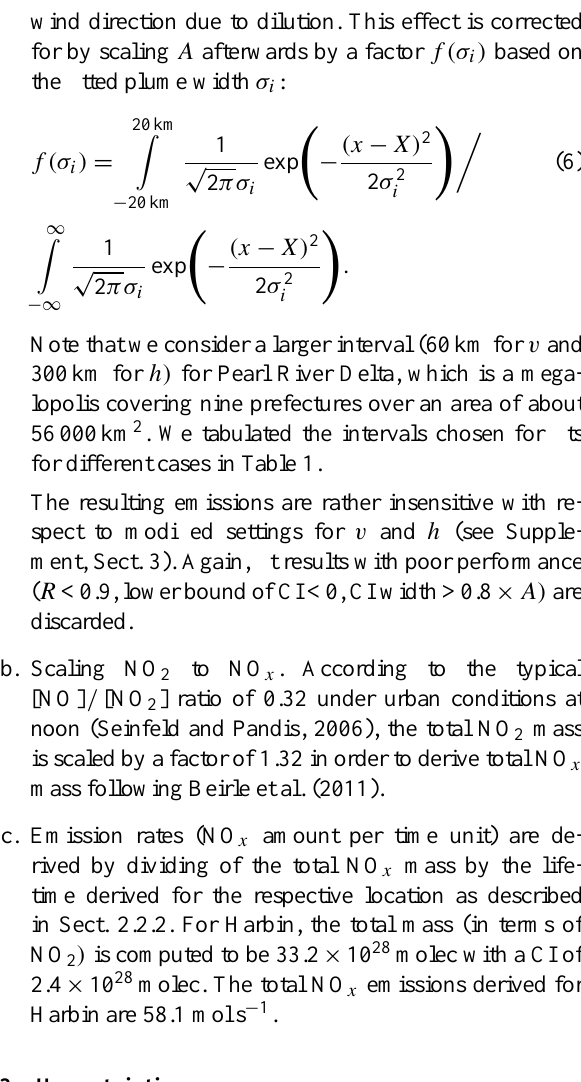
Table 1. Intervals chosen for the fit of the NO x lifetime and total mass. Category Interval (km) Wind Across-wind direction (fit) direction (integration) Fit lifetime f i 600 300 Fit total mass h v Power plant 100 40 City 200 40 Pearl River Delta 300